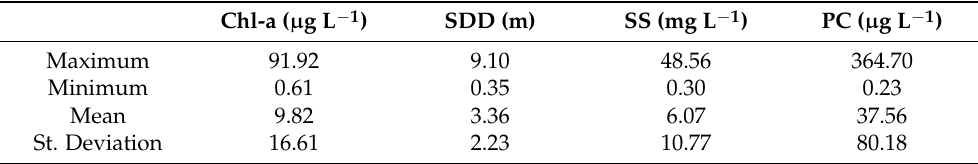
Table 4. Descriptive statistical values of chlorophyll-a (Chl-a), Secchi disk depth (SDD), suspended solids (SS), and phycocyanin (PC).